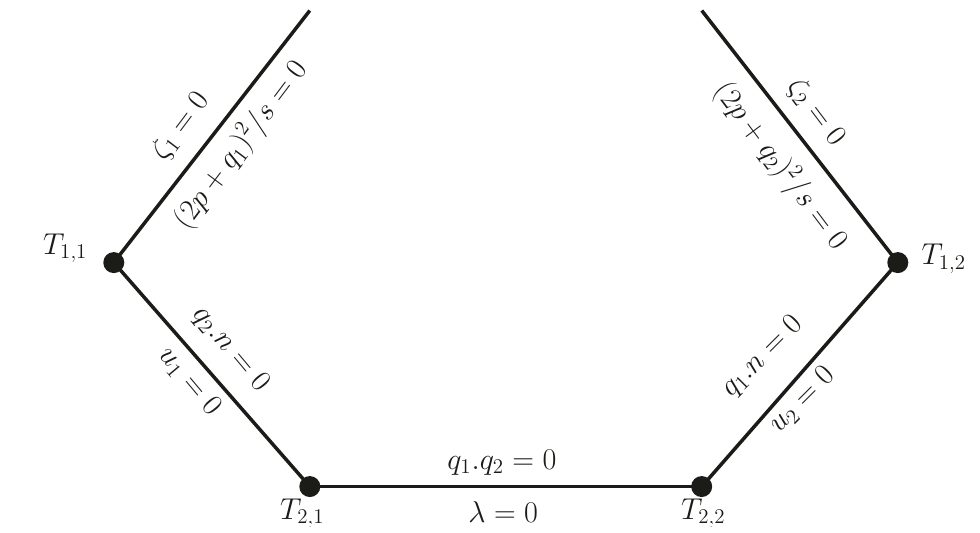
Figure 2 . Representation of the singular regions for the integration of the real emission amplitude. Each line represents a speci(cid:12)c limit, which is speci(cid:12)ed in terms of Lorentz invariants in the inner part of the (cid:12)gure. A line represents a phase-space boundary that gives a single pole in (cid:15) . A dot connecting two lines represents a phase-space region leading to a double pole in (cid:15) . For each dot, there is a speci(cid:12)c subtraction term T ( gg ) appearing in eq. (3.19) whose integral includes the double i;j pole. The subtraction of the single pole associated with a line connecting two dots is shared among the two subtraction terms associated with these